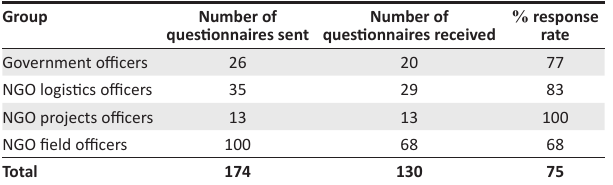
TABLE 2: Response rate.